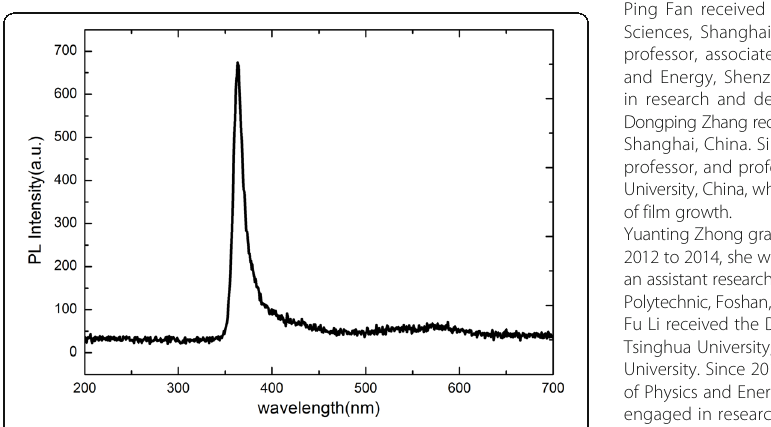
Fig. 5 Photoluminescence (PL) spectra of the GaN nanowall network measured at room